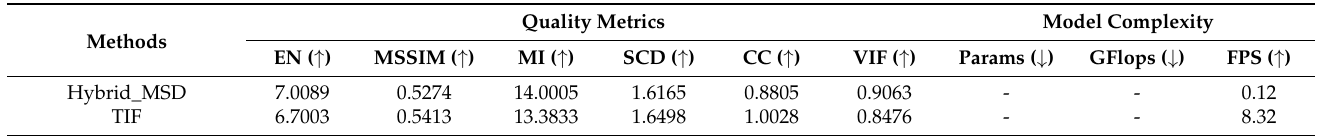
Table 6. Comparison results on the TNO and RoadScene data with several recently published methods. Bold represents for the best result in comparison. ↑ indicates the larger value the better and ↓ means the